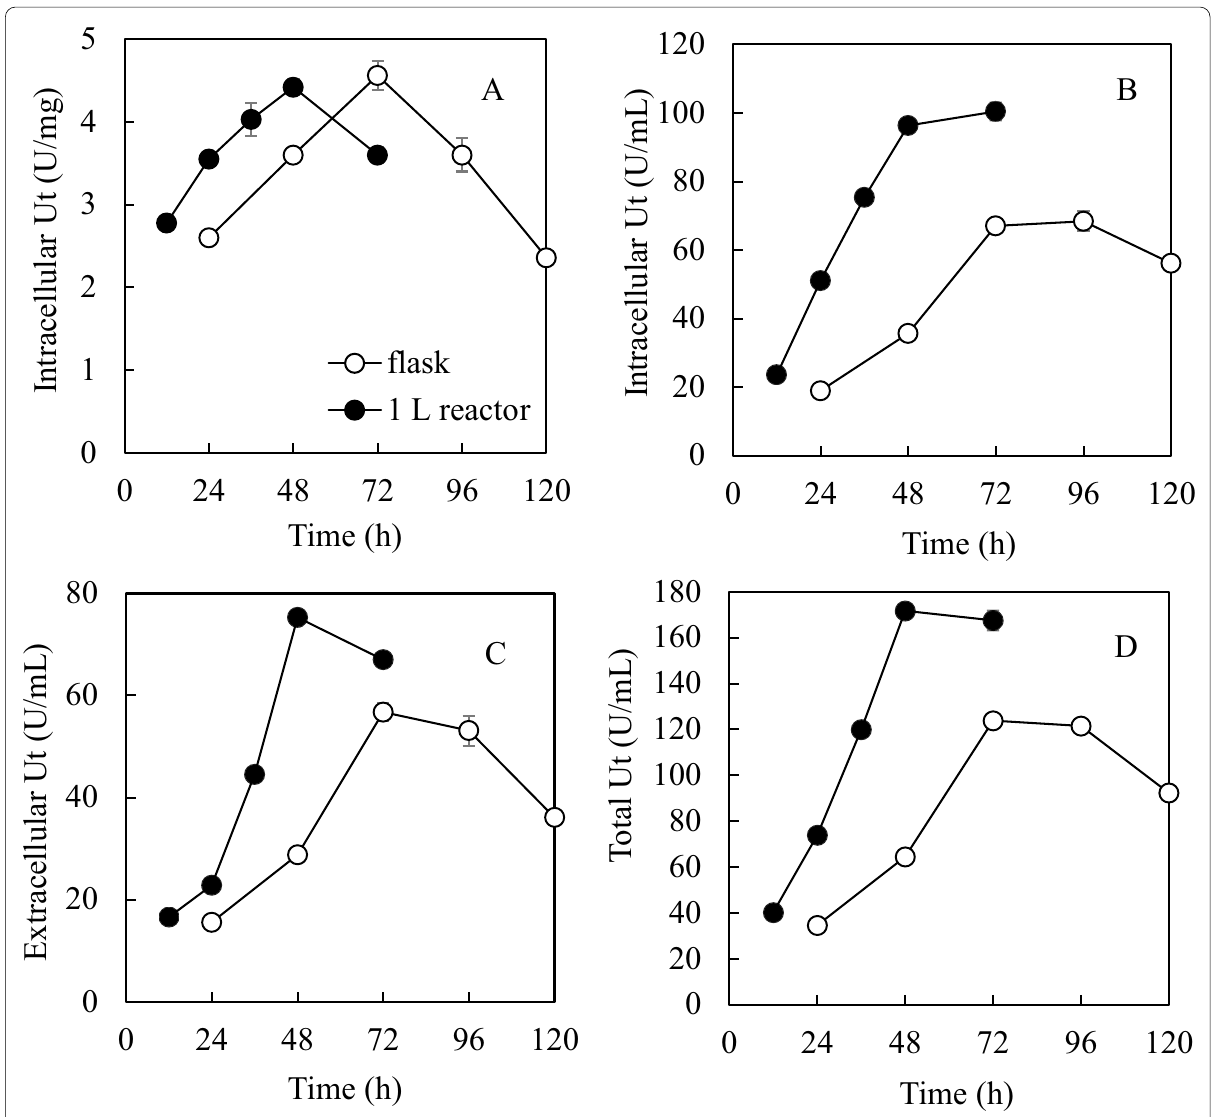
Fig. 4 Comparison of specific intracellular transfructosylating activity ( A ), and intracellular ( B ), extracellular ( C ) and total ( D ) enzyme activities based on per unit of volume in shake flasks and 1 L reactor. Nutrient conditions shown in Fig.